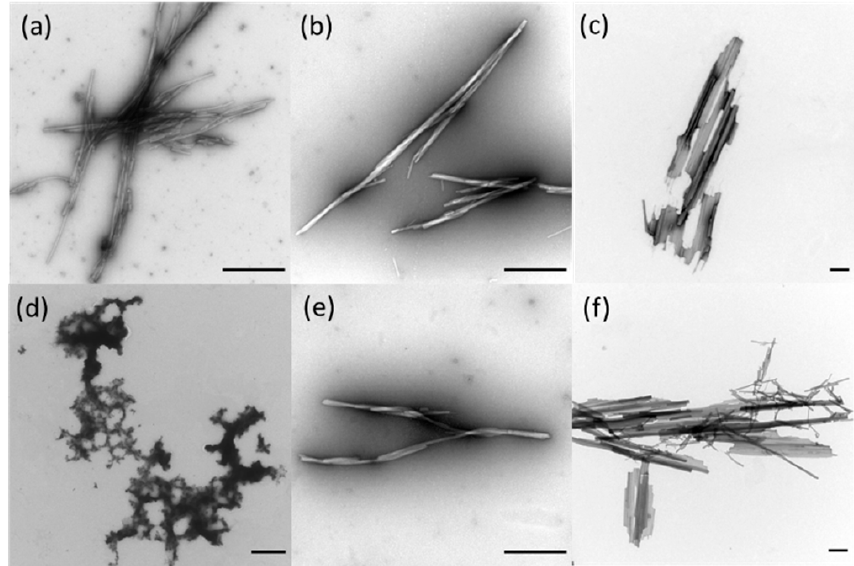
Figure 7. TEM recordings of fibrils obtained from PTH 25–37 , cis -AzoPTH 25–37 , and trans -AzoPTH 25–37 at 37 °C after 20 h (scale bar = 500 nm): ( a ) trans- AzoPTH 25–37 (100 μ M), ( b ) trans- AzoPTH 25–37 :PTH 25–37 (100 μ M:100 μ M), ( c ) trans -AzoPTH 25–37 :PTH 25–37 (10 μ M:100 μ M), ( d ) cis- AzoPTH 25–37 (100 μ M), ( e ) cis- AzoPTH 25–37 :PTH 25–37 (100 μ M:100 μ M), and ( f ) cis- AzoPTH 25–37 :PTH 25–37 (10 μ M:100 μ M).